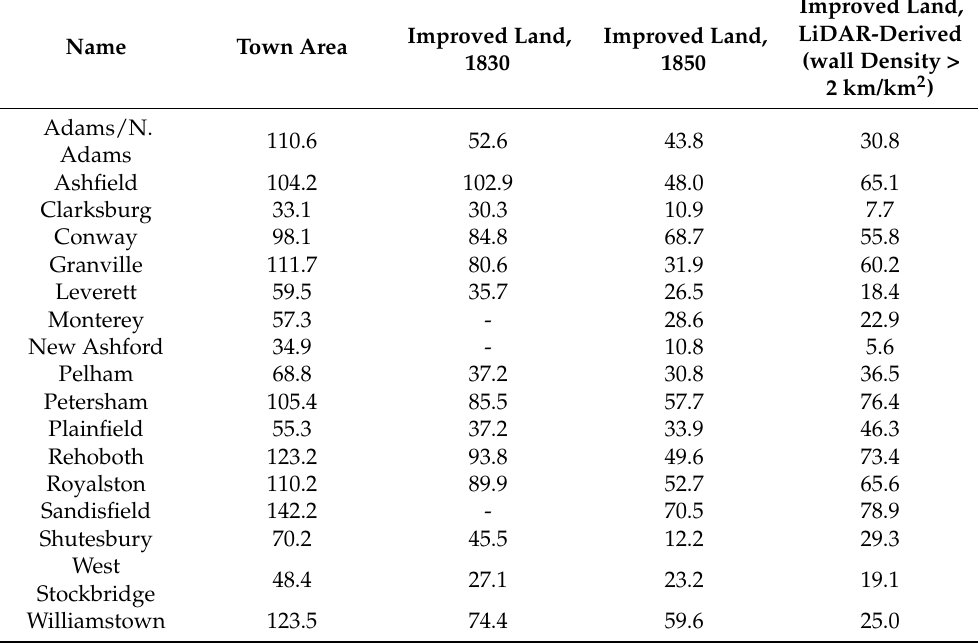
Table 3. Comparison of improved land area values (km 2 ) for 1830, 1850, and LiDAR-derived